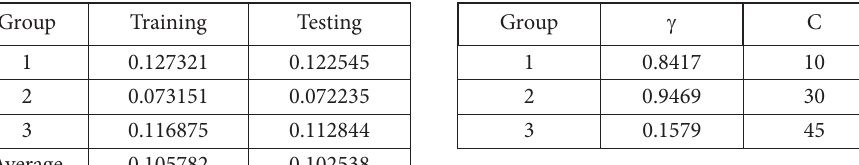
Table 7. Kernel ( g ) and penalty (C) parameters